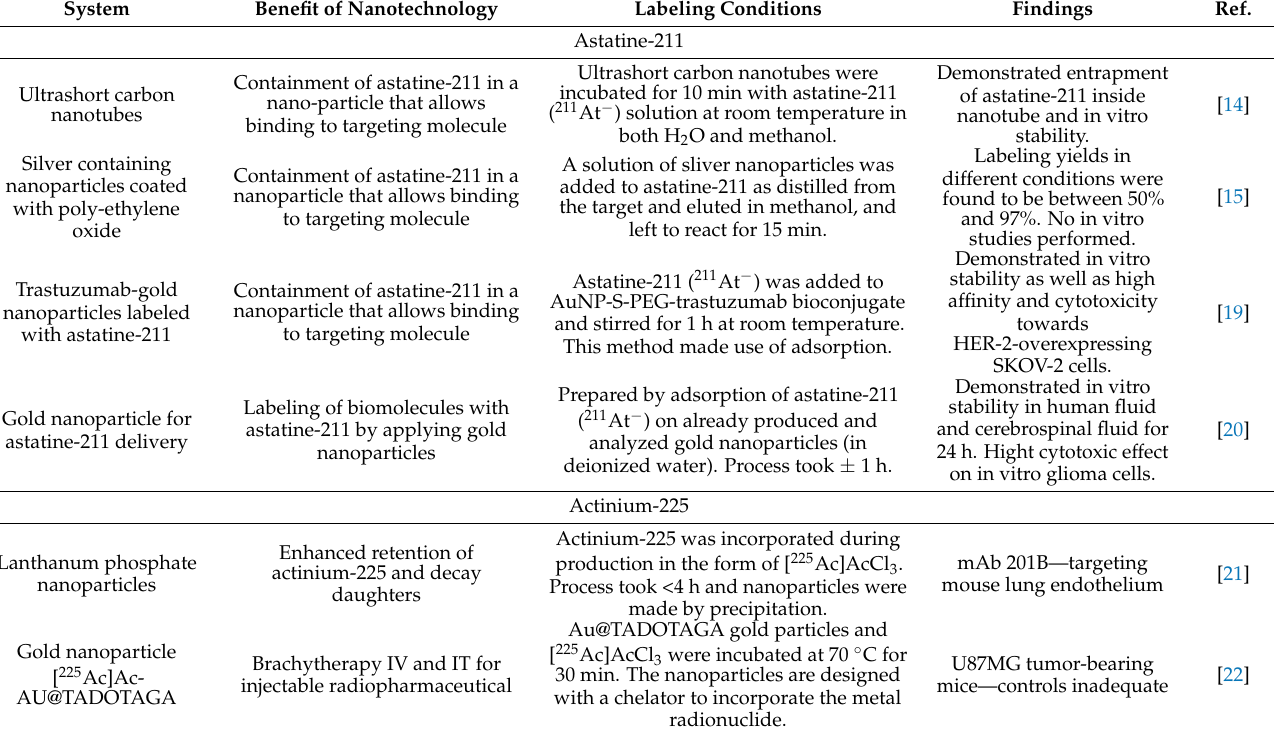
Table 1. Overview of current preclinical TAT nanotechnology